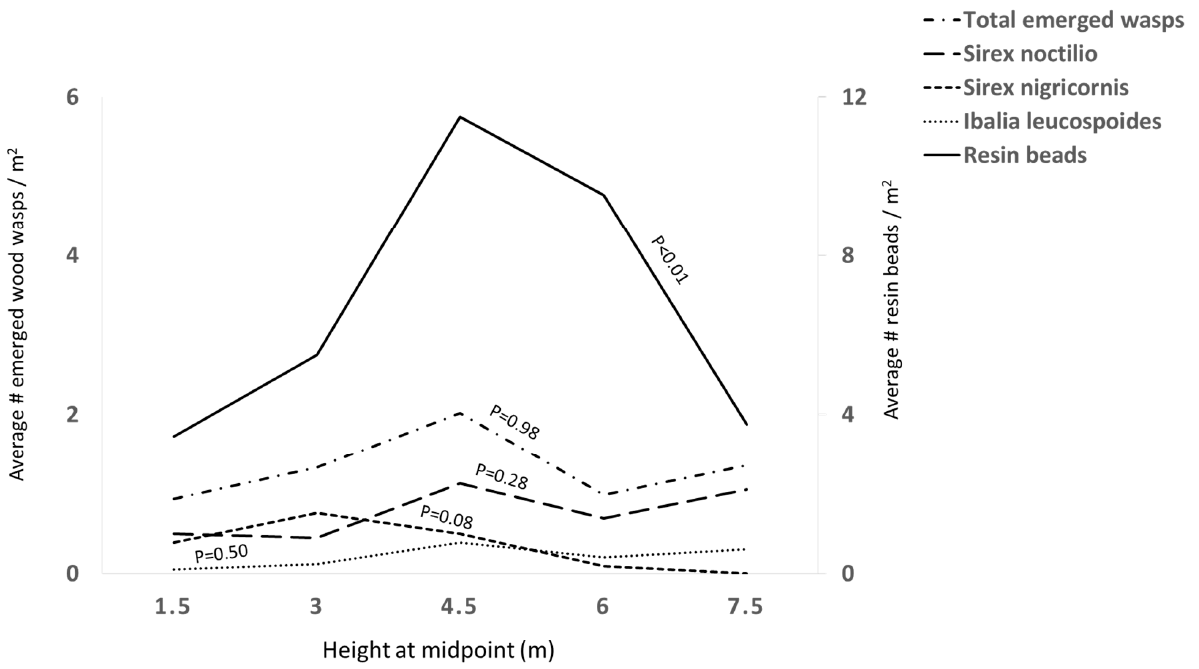
Figure 1. The density of resin beads per square meter on red pines, Pinus resinosa , by cardinal direc- tion. The asterisk (*) indicates significantly lower resin bead density ( p = 0.04).